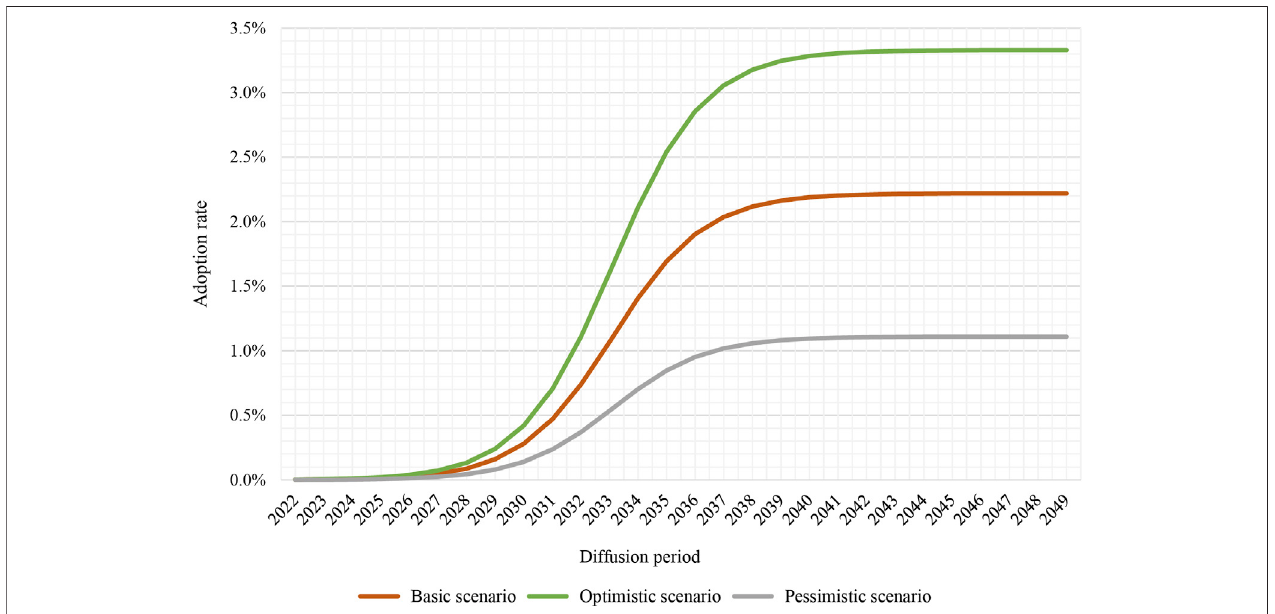
FIGURE 2 | Adoption curves at the regional level for the basic, optimistic and pessimistic scenarios of the economic surplus model.